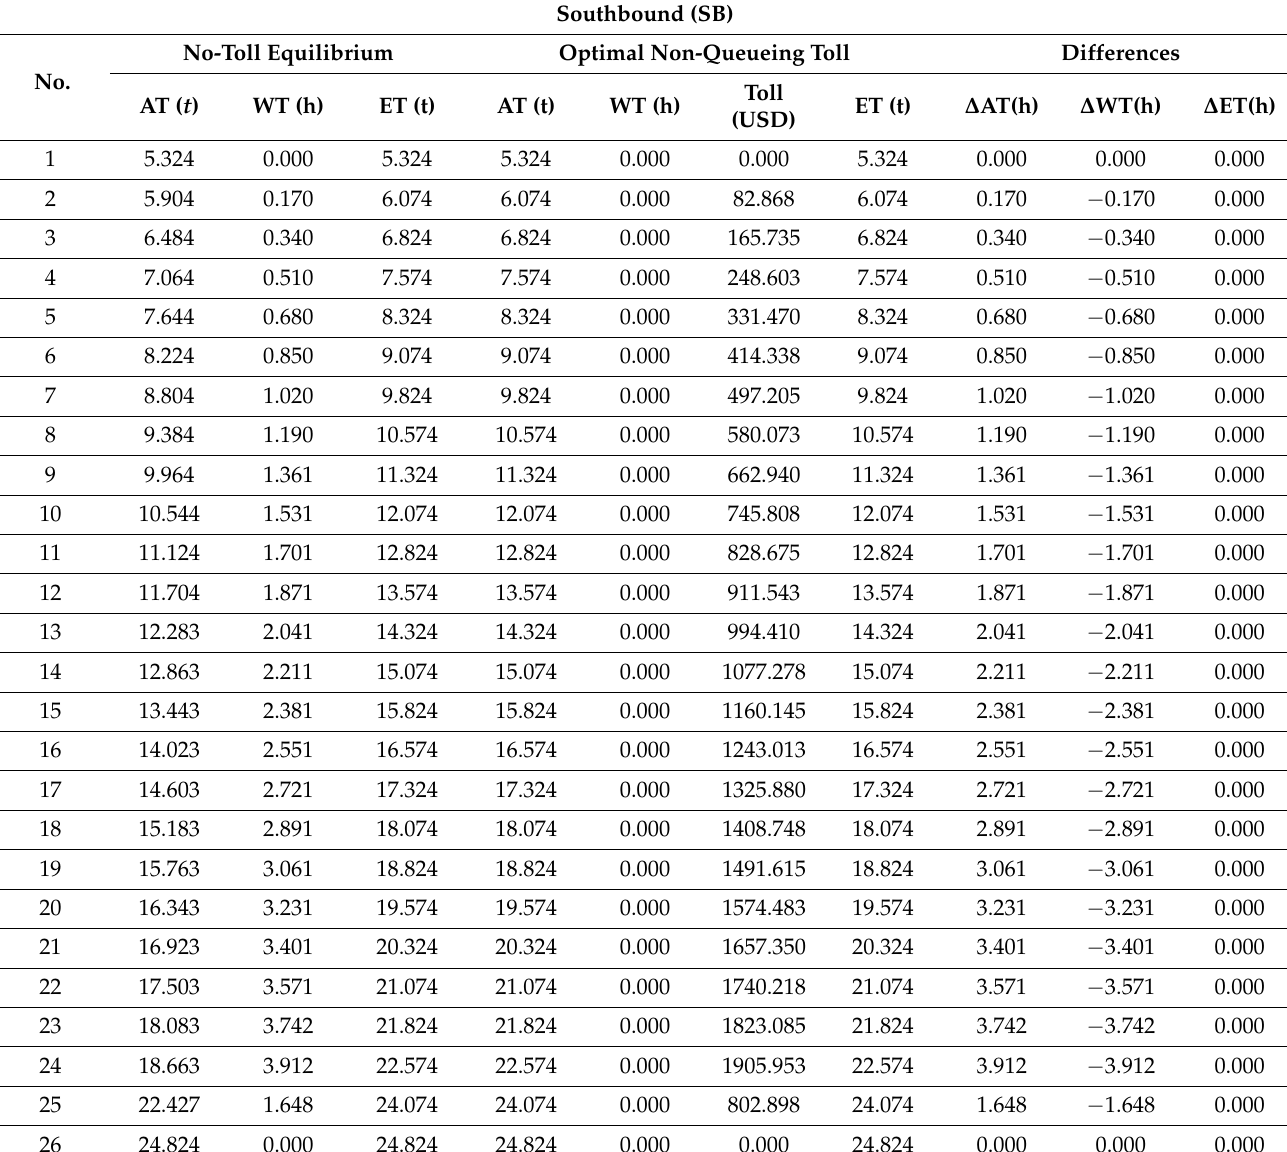
Table 9. Numerical results according to timetable for southbound ships from the no-toll to the tolled